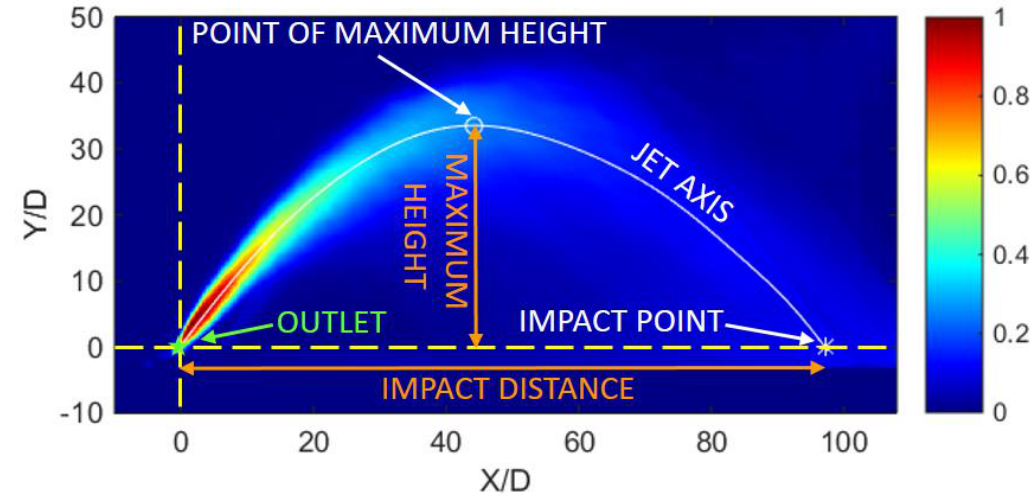
Figure 4. Non-dimensional mean concentration C/C 0 fields for the same inclined NBJ of Figure 2 released into a stagnant receiving body, with the jet geometrical features; the maximum uncertainty in the mean concentration measurement is ±4.41%.